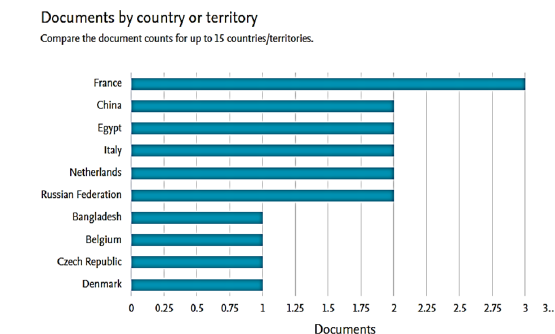
Fig. 4. Countries that published related to the words “brick”, “reduces” and “humidity” Source: Scopus scien- tific